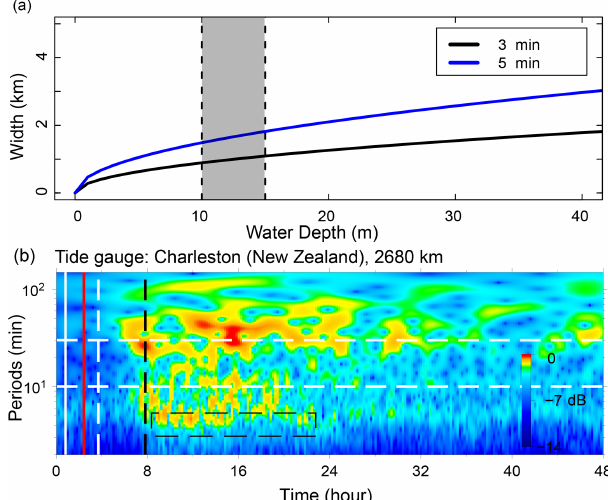
Figure 9. Mechanism of the tsunami component with a 3–5min period. (a) The source dimension estimated by Eq. (4). (b) Wavelet analysis of tide gauge at Charleston, New Zealand, 2680km away from the eruption site. The solid vertical white line marks the arrival time with a travelling velocity of 1000ms − 1 . The solid vertical red line marks the arrival of the Lamb wave. The dashed vertical white line marks the lower limit of AGWs’ velocity of 200ms − 1 . The dashed vertical black line marks the theoretical tsunami